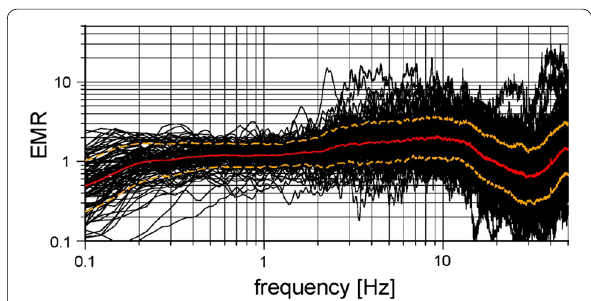
Fig. 9 Averaged EMR (red), the average (orange), and individual EMRs (black) for the 100 K-NET and KiK-net sites